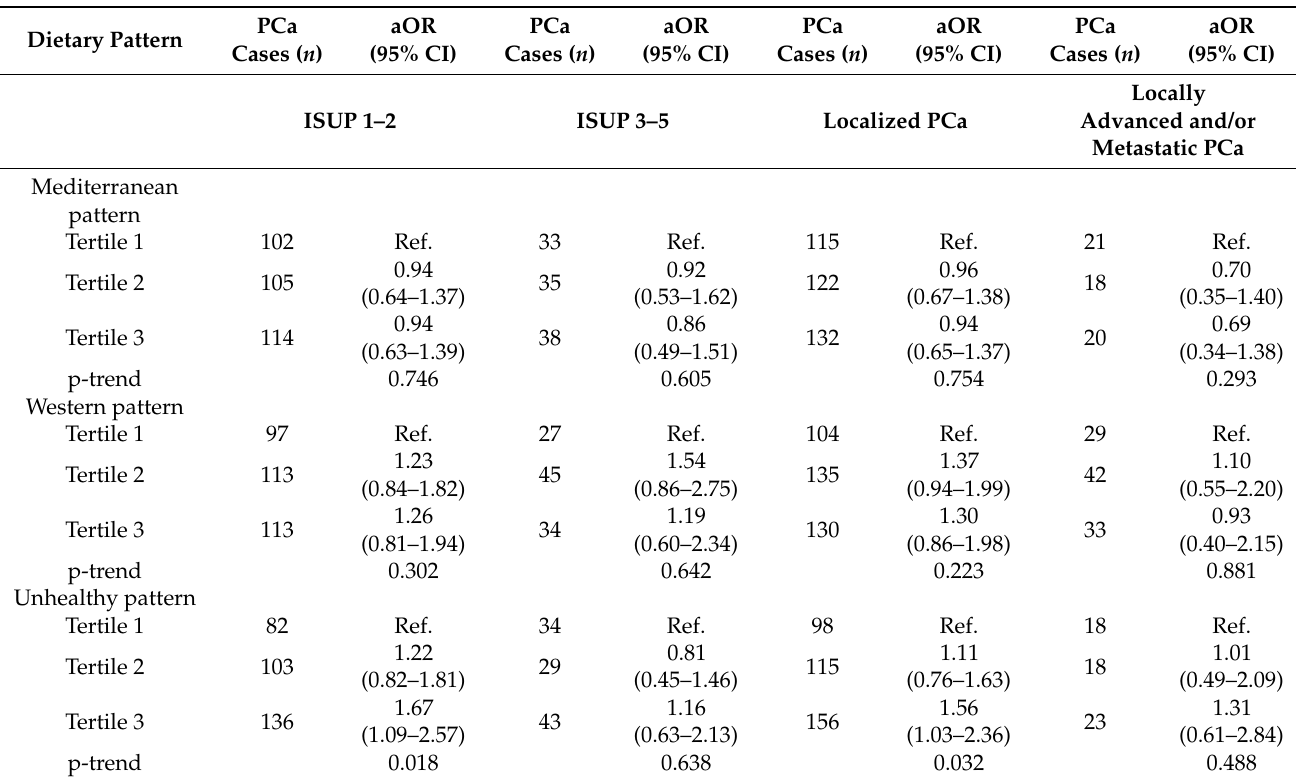
Table 4. Association between dietary patterns and PCa according to tumor aggressiveness (ISUP) and extension in the CAPLIFE